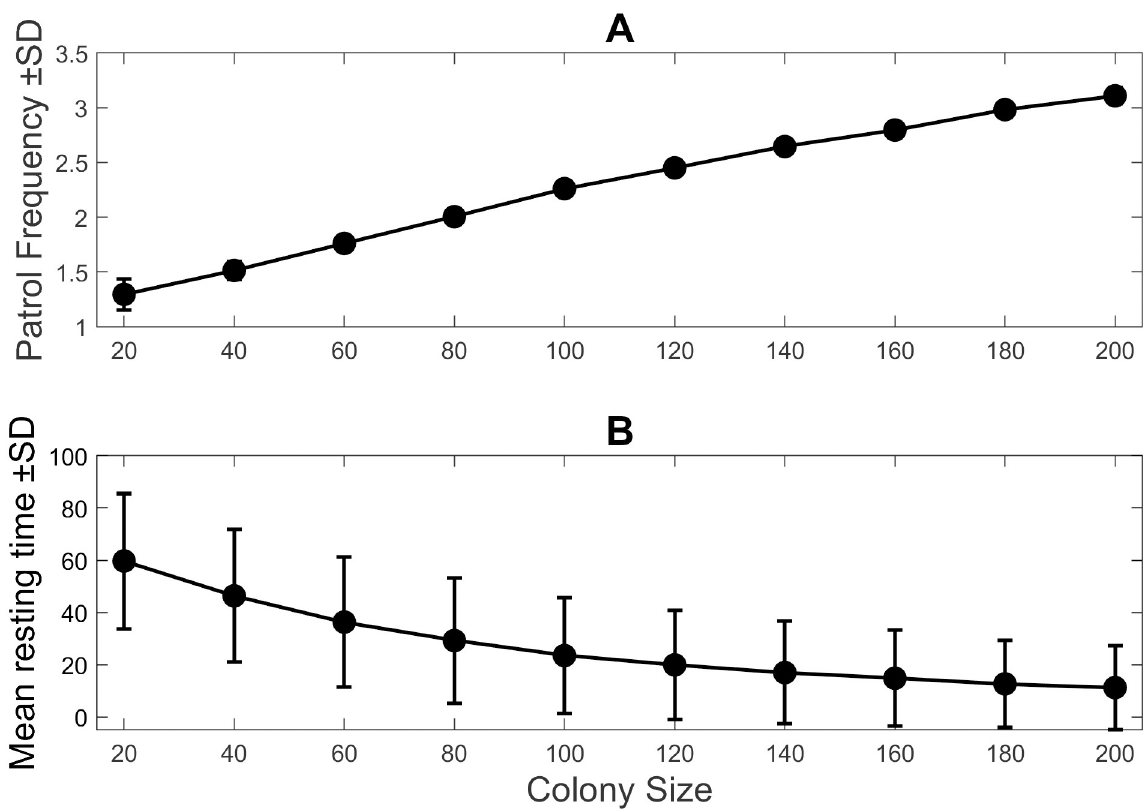
Fig 4. Patrol frequency and encounters. (A) Patrol frequency of the queen as a function of the colony size. The patrol frequency of the queen increases as the colony size increases. This shows an increase in patrol effort by the queen. (B) Resting time as a function of the colony size shows an inverse relationship to the patrol frequency. The mean resting time decreases with colony size as the queen spends more time patrolling